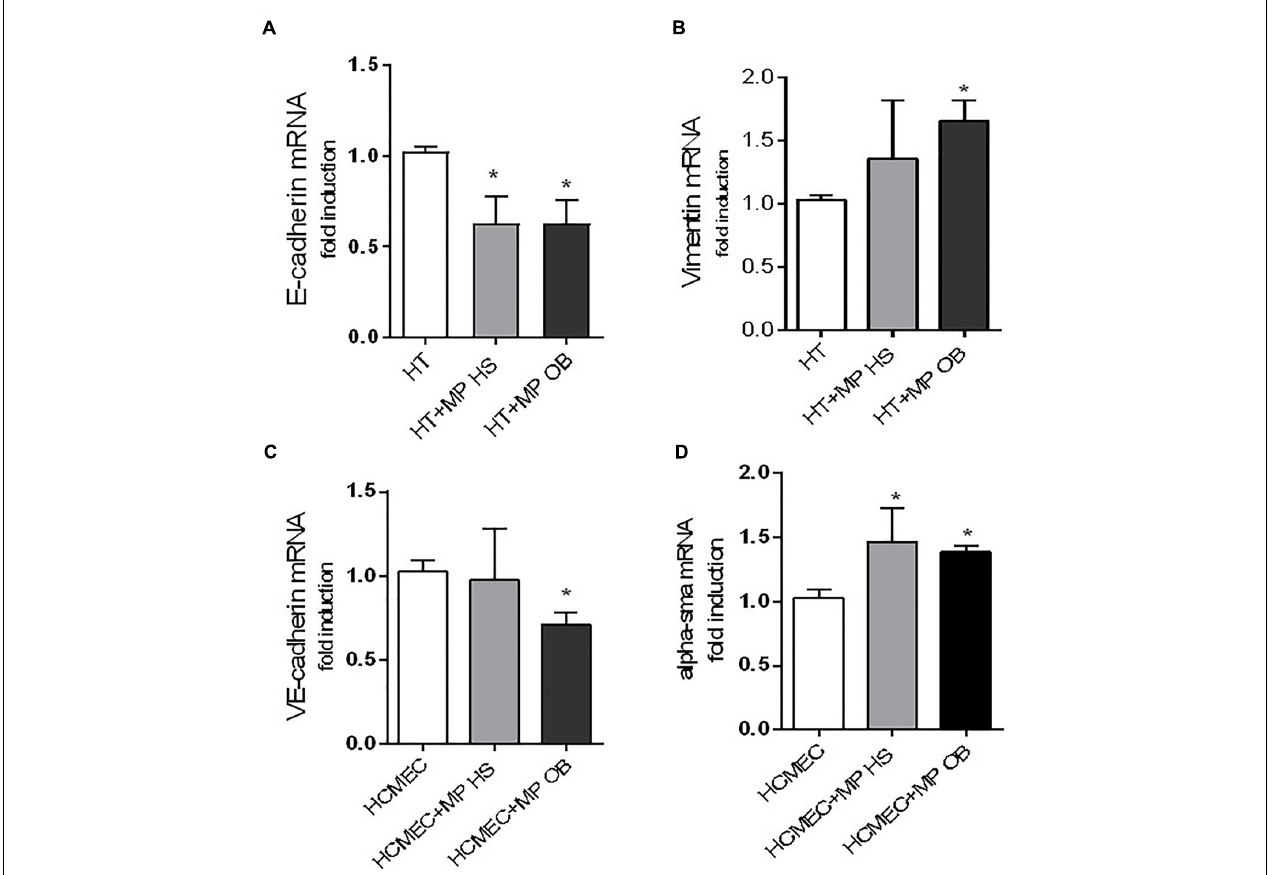
FIGURE 9 | Effects of MPs on the expression of gene markers of EMT and EndMT. Co-culture experiments between colon adenocarcinoma cells HT29 (0.25 × 10 6 ) (A,B) or human coronary microvascular endothelial cells (HCMEC) (0.25 × 10 6 ) (C,D) and MPs (0.25 × 10 8 ) from obese (OB) and healthy (HS) individuals for 24 h were reported. Gene expression was evaluated by qPCR and normalized to those of GAPDH as control and expressed as fold-change. Data are reported as mean ± SEM ( n = 4, for each experimental condition); ∗ P < 0.05 vs. HT29 cultured alone or HCMEC cultured alone.